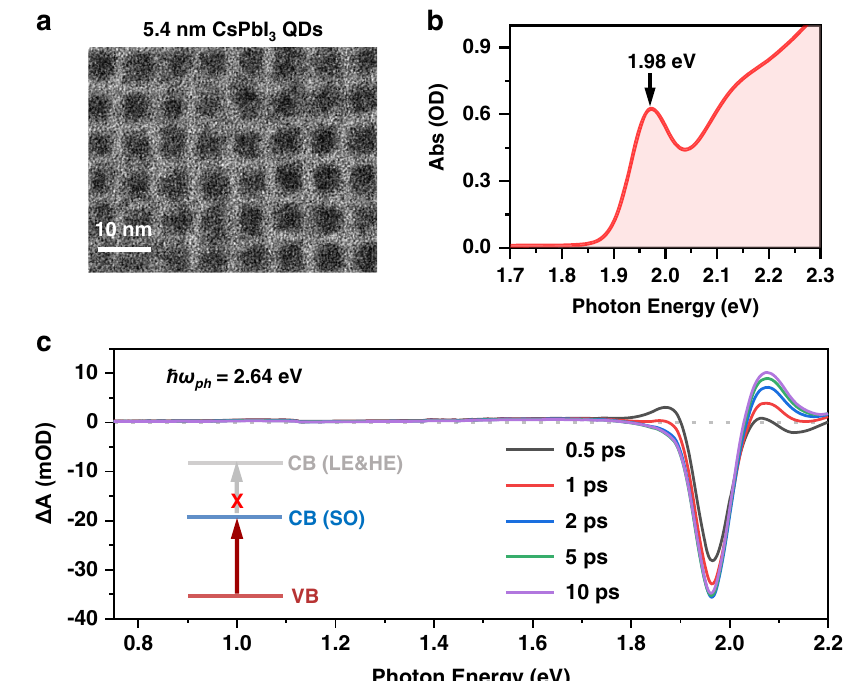
Fig. 2 | Characterization of CsPbI 3 QDs. a A representative transmission electron microscopy(TEM)image. b Steady – stateabsorptionspectrum,withtheband-edge exciton peak at ~1.98eV. c Broadband transient absorption (TA) spectra at varying delay times, pumped at 2.64eV (470nm), displaying negligible photoinduced